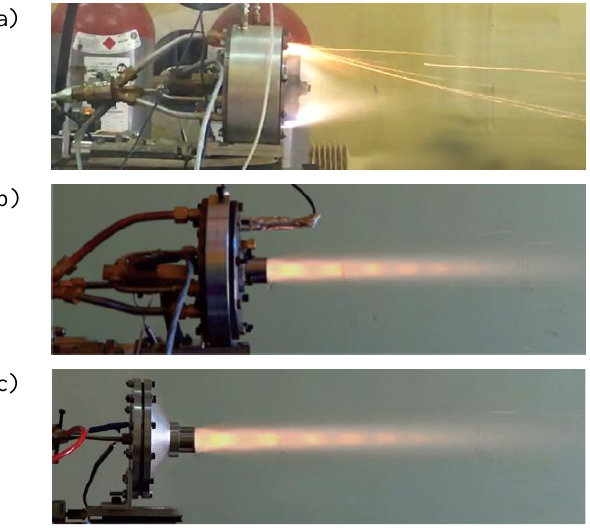
Fig. 10. Rocket RDE: with annular cylindrical detonation chamber (a), with disc-shaped detonation chamber (b) and with con-shaped detonation